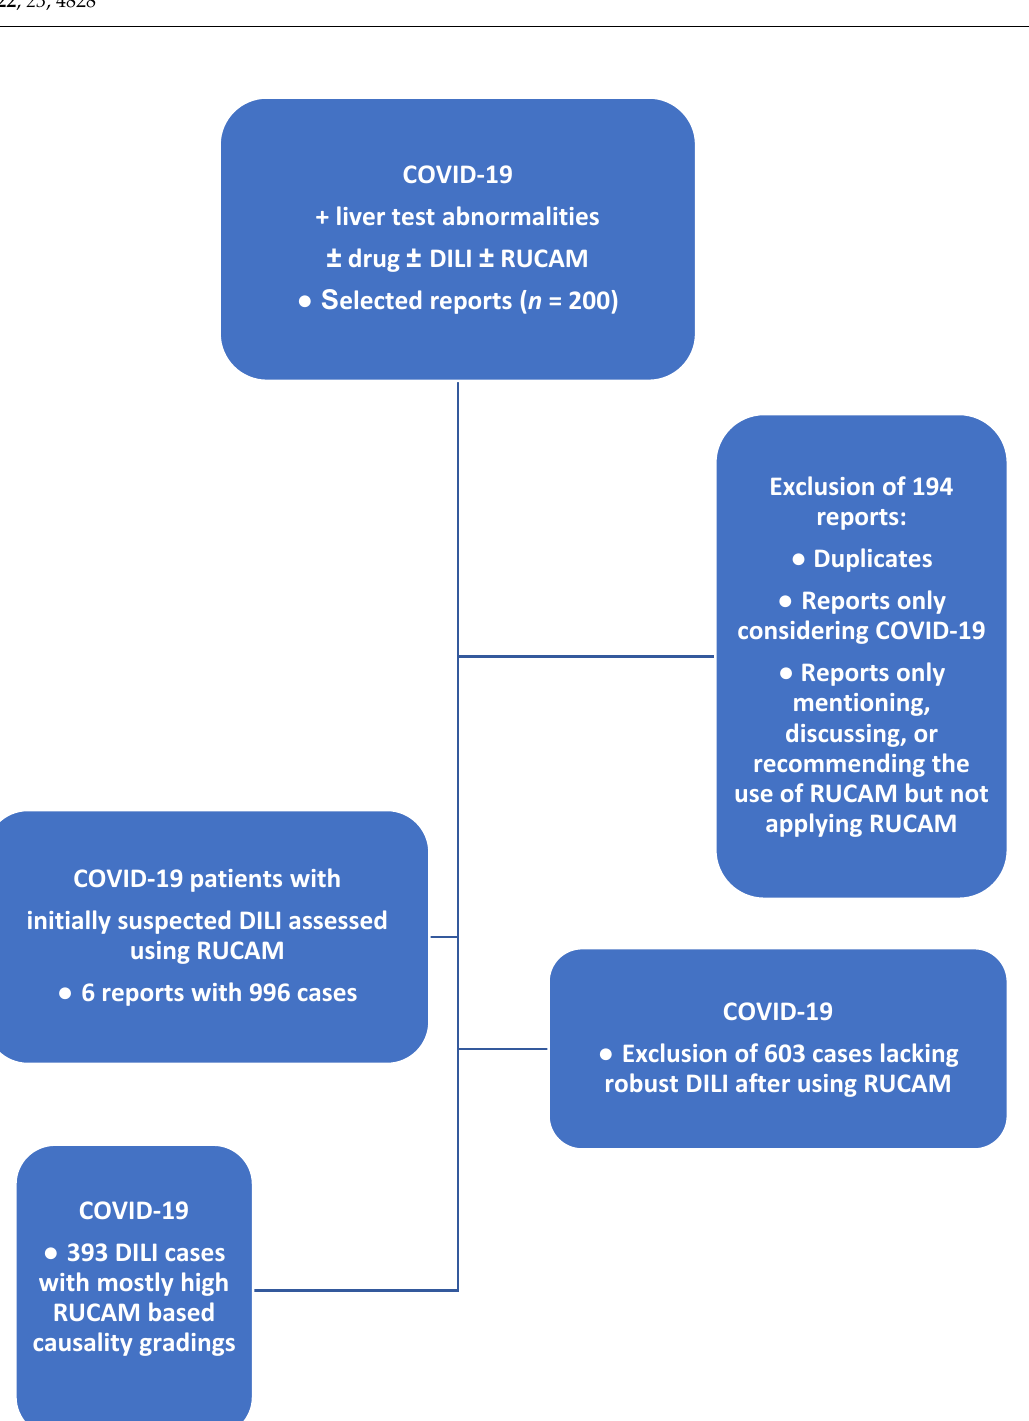
Figure 1. Flow diagram of literature search and study process of RUCAM ‐ based DILI cases in COVID ‐ 19 patients. Abbreviations: COVID ‐ 19, coronavirus disease 2019; DILI, drug ‐ induced liver injury; RUCAM, Roussel Uclaf Causality Assessment Method.